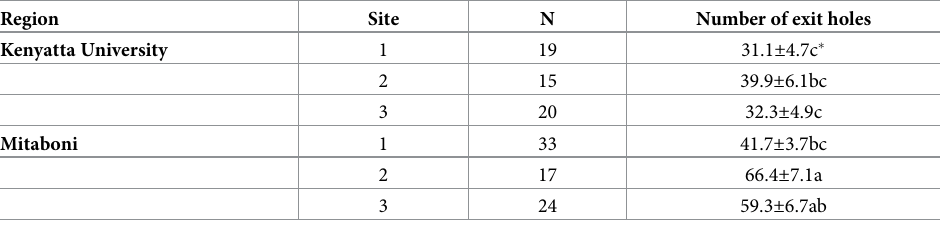
Table 5. Mean ±SE number of exit holes of wood-boring beetles on Acacia xanthophloea at Kenyatta University and